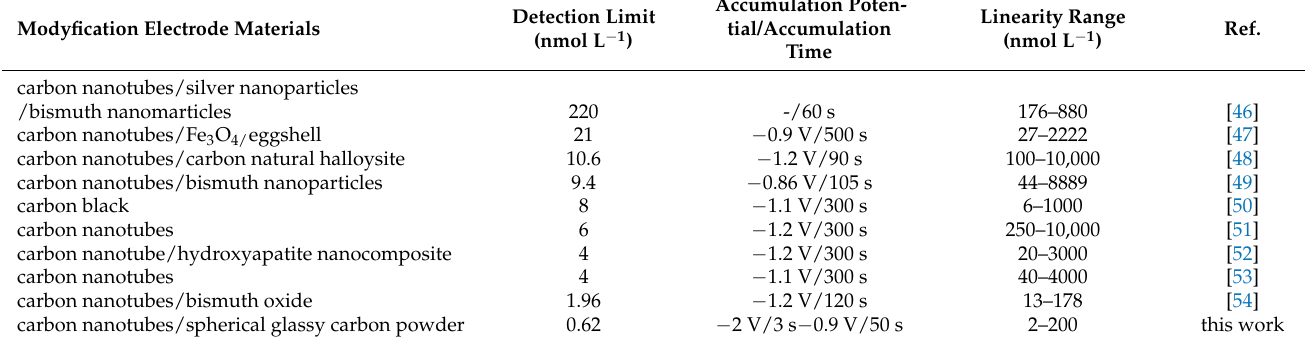
Table 1. An overview of electrodes based on low-dimensional carbon nanostructures used for the determination of Cd(II) by the ASV method. The publications are ranked according to decreasing limit of detection.